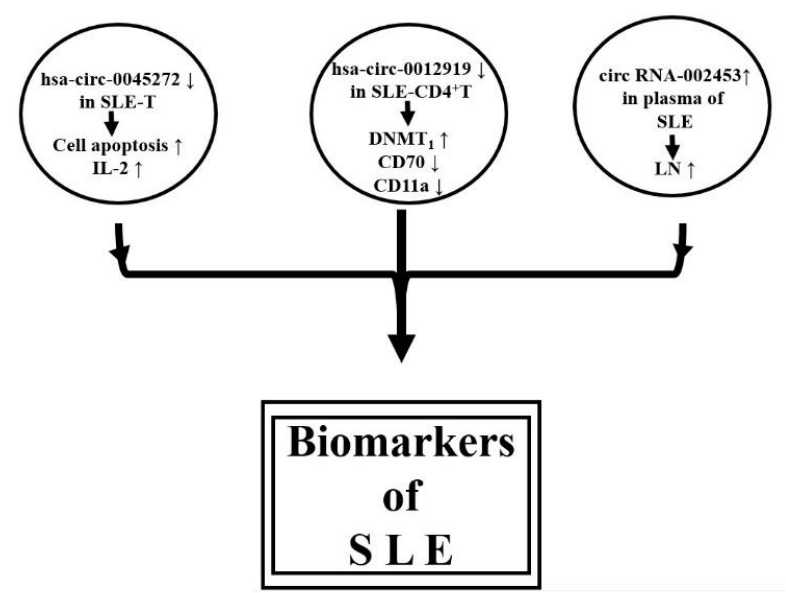
Figure 5. Proposed acting mechanisms of circRNAs in the pathogenesis and as biomarkers in